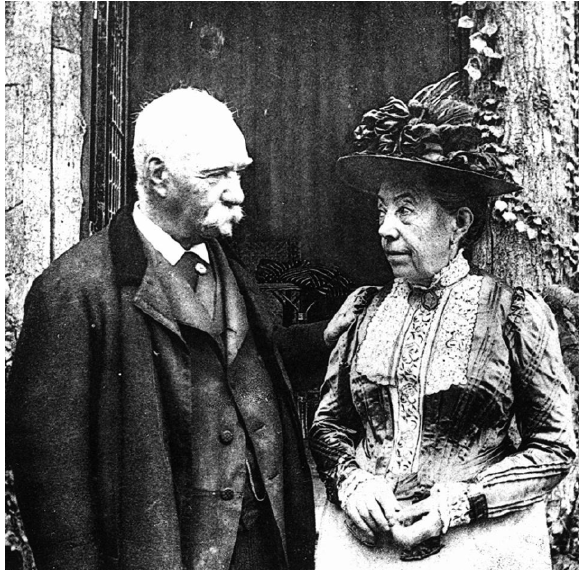
Figure 6. Laussedat and his wife in